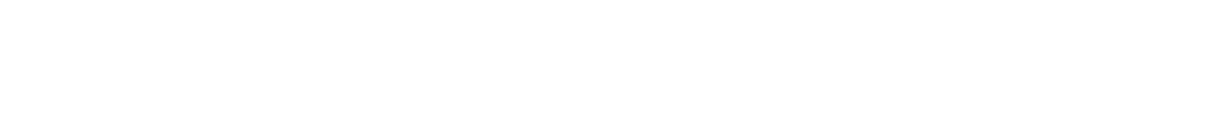
FIGURE 12 | Patient 5’s dEEG cortical source coherence peaks (highest 100 of ∼ 6400) for pre-spike (A), spike (B), and post-spike (C) intervals of the five frequency